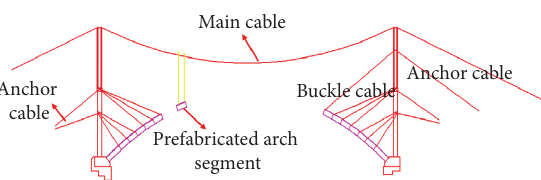
Figure 1: Bracket pouring method.